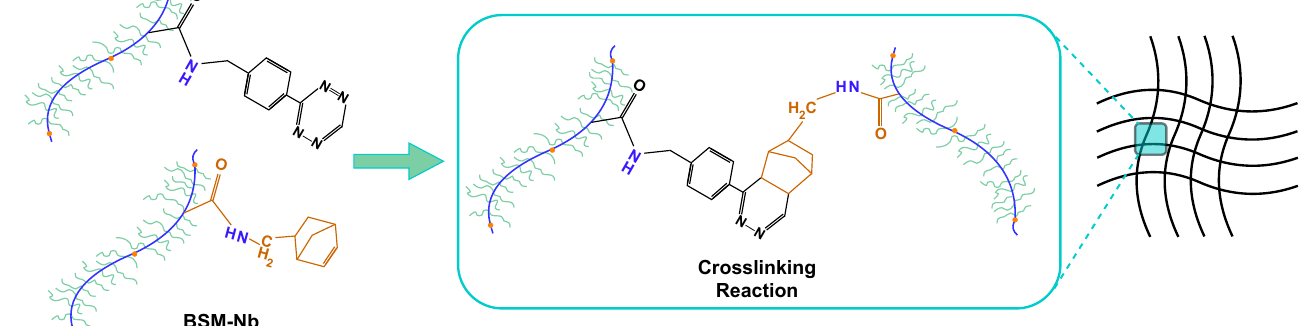
Figure 5. Tetrazine (Tz) and norbornene (Nb) conjugated to BSM and the crosslinking reaction [28]. The synthesis was performed as follows. MES buffer (0.1 M MES, 0.3 M NaCl, and pH 6.5) was used to predissolve BSM at 10 mg/mL. To this reaction mixture, 1-ethyl-3-(3-dimethylaminopropyl) carbodiimide (EDC; 4 mmol per gram of dry mucin) and N-hydroxysuccinimide (NHS; 4 mmol per gram of dry mucin) were added and stirred for 15 min. After that, 1 mmol of Tz and 2 mmol of Nb were added individually to